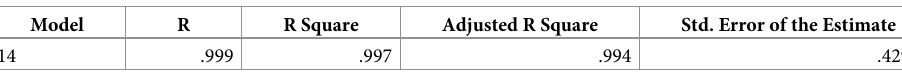
Table 5. Model summary.